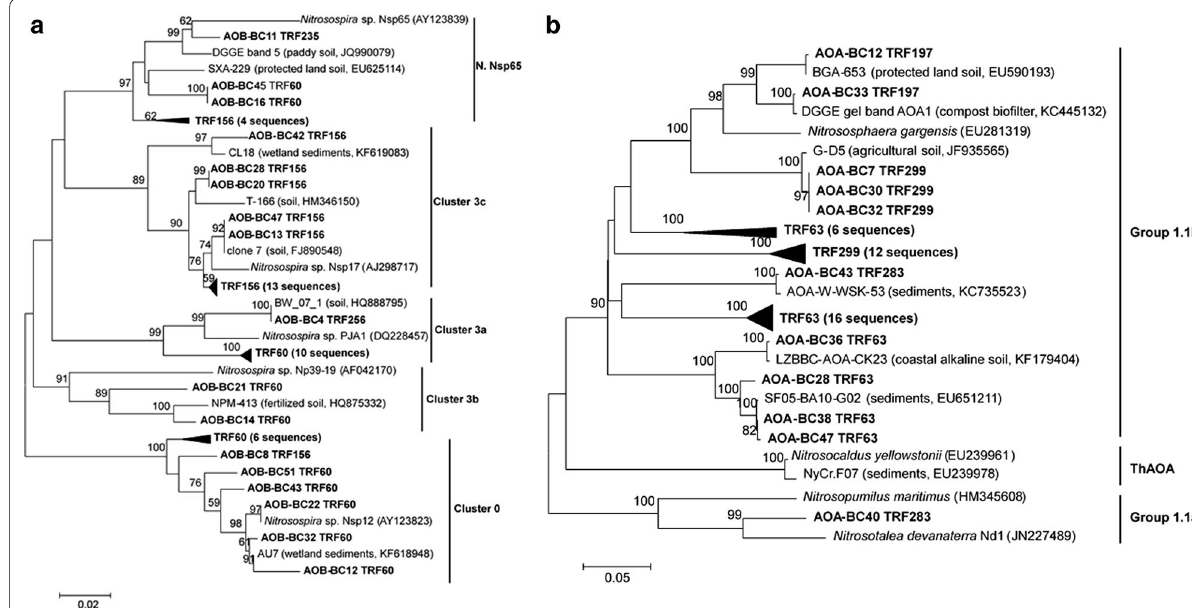
Fig. 5 Neighbor‑joining phylogenetic tree of a bacterial amo A sequences and b archaeal amo A sequences retrieved from the vegetable soil. Sequences from this study are shown in bold and described as clone name (accession number) T‑RF size. Reference sequences are described as clone name (environment, accession number). Bootstrap values (> 50%) are indicated at branch points. The scale bar represents 5% estimated sequence divergence. The accession numbers in GenBank were